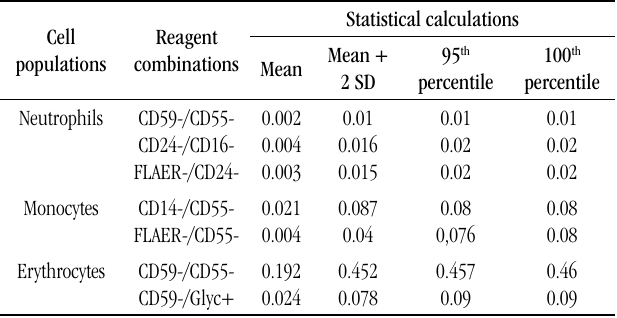
tABLE 2 – Measures of central tendency, dispersion and percentiles of control samples, expressed in percentage of altered cells in relation to the total analyzed events, fractioned by cell populations and reagent